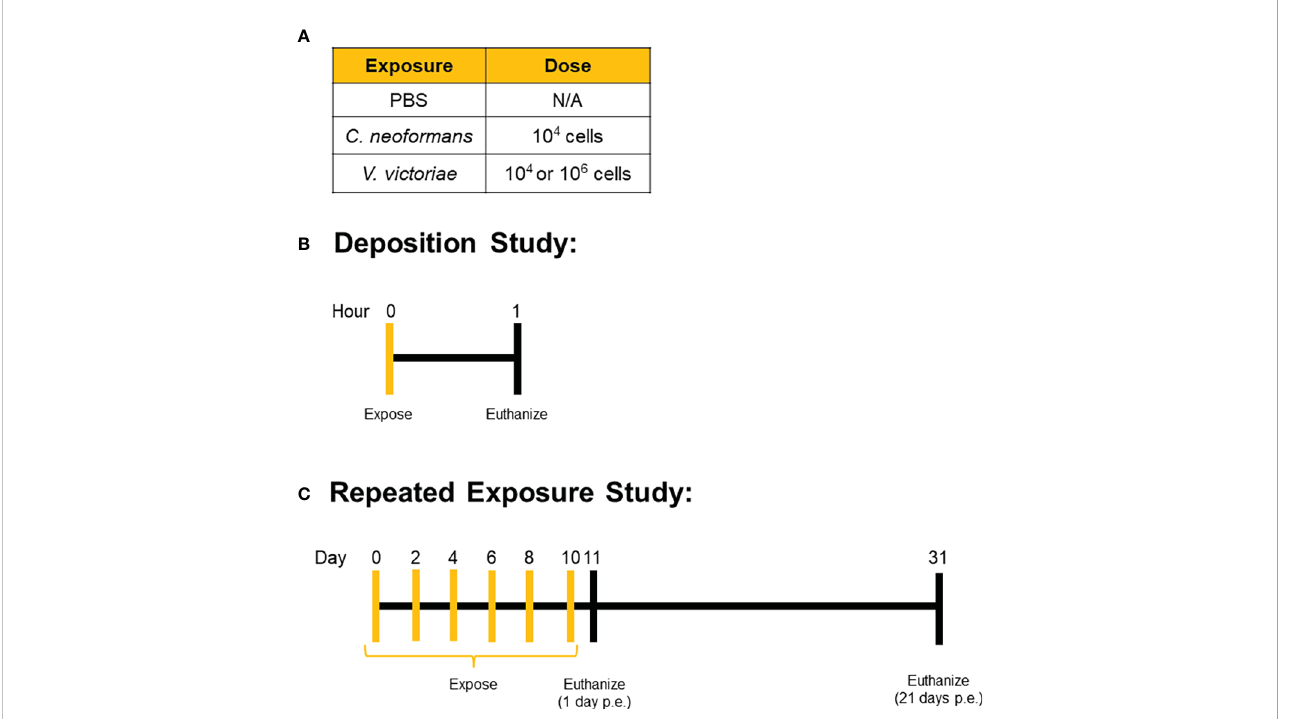
FIGURE 1 Exposure Paradigms. Mice were exposed to (A) set doses of either C. neoformans , V. victoriae , or PBS control via oropharyngeal aspiration. (B) Deposition was con fi rmed by exposing mice one time and then collecting tissue for analysis approximately 1 hour after the exposure. (C) For the repeated exposure study, mice were repeatedly exposed to the same dose of yeast or PBS control every other day for a total of six exposures, with tissue collection occurring either 1 day or 21 days after the fi nal